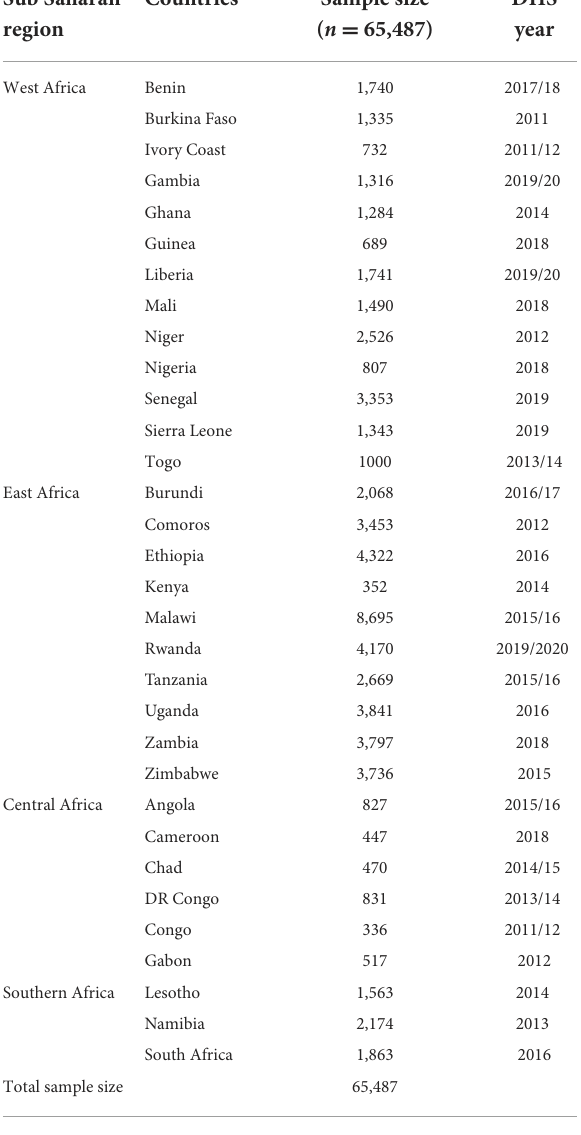
TABLE 1 Sample size calculation (country and DHS-year wise) in the study of pooled prevalence and determinants of informed choice of contraceptive methods among reproductive age women in Sub Saharan Africa (2010–2020 DHS). Sub Saharan Countries Sample size DHS region ( n = 65,487) year